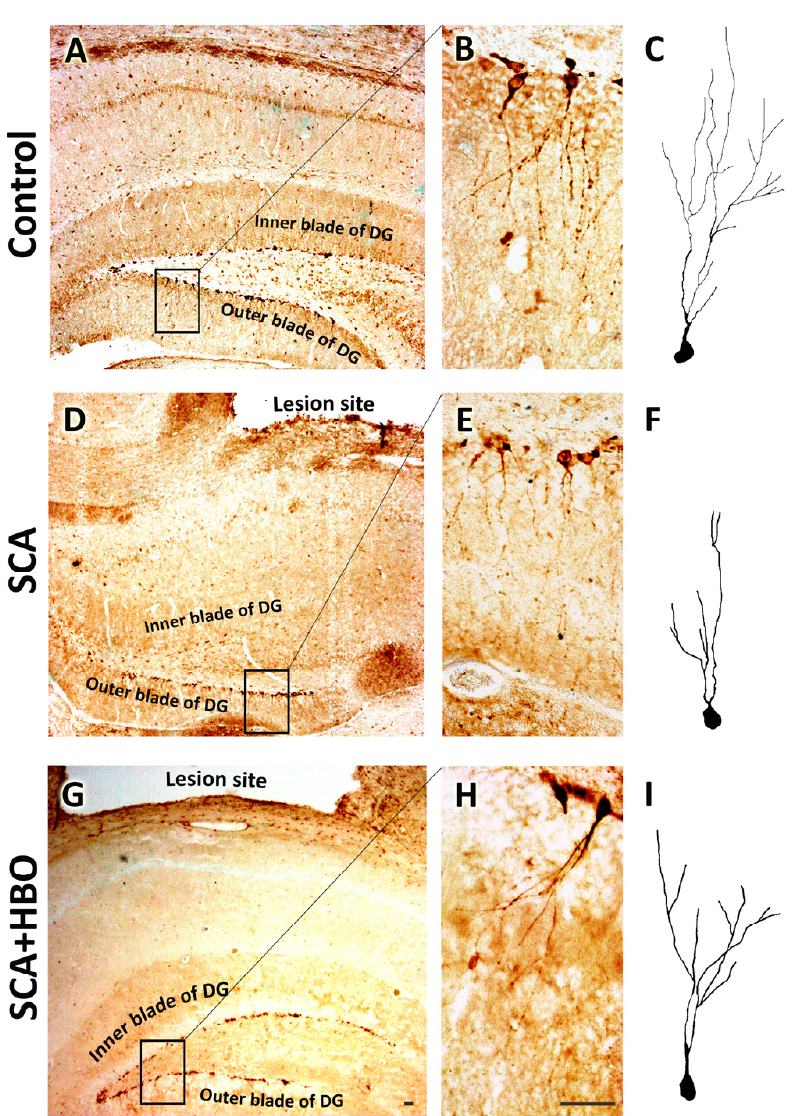
Figure 4. Besides prevention of SCA (suction cortical ablation)—which caused the neuronal loss, HBOT (hyperbaric oxygen therapy) impends dendrite degeneration of immature neurons in the SGZ (subgranular zone) as well. ( A , B ) In the control sections, DCX-stained immature neurons are in the SGZ, with dendrites branching in the inner- and mid-third of the granule cell layer (GCL) until the molecular layer. ( C ) The reconstructed neuron in the control group. ( D , E ) SCA causes the loss of neurons in the inner blade. ( E ) Higher magnification of the outer blade reveals that neurons in the SGZ show significant morphological changes manifested by dendritic shrinkage and reduction of arborization. ( F ) Reconstructed neuron after SCA. ( G , H ) HBOT protects neurons in the SGZ and pre- vents dendritic degeneration. ( I ) Reconstructed neuron following HBOT. Rectangles indicate where the high-magnification images are taken. Scale bars: ( A , D , G )—50 µ m, and ( B , C , E , F , H , I )—10 µ m.